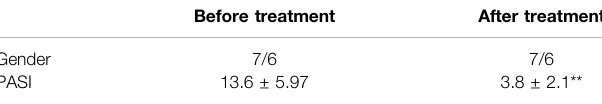
TABLE 2 | Characteristics of the study cohorts. Before